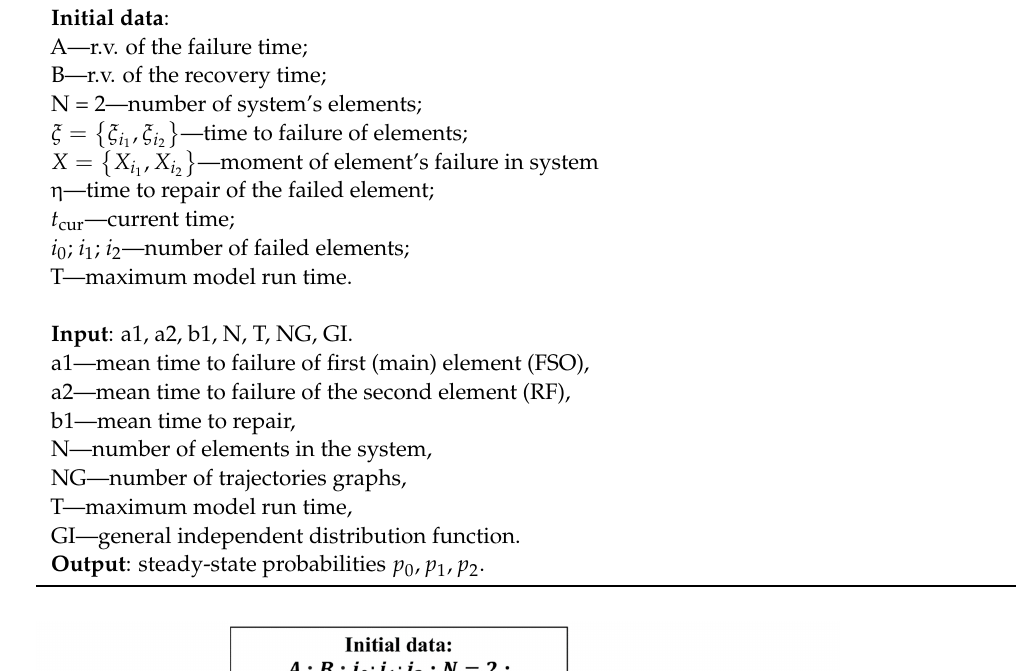
Algorithm 1 . Simulation model for assessing steady-state probabilities of the system < GI 2 /GI/ 1>